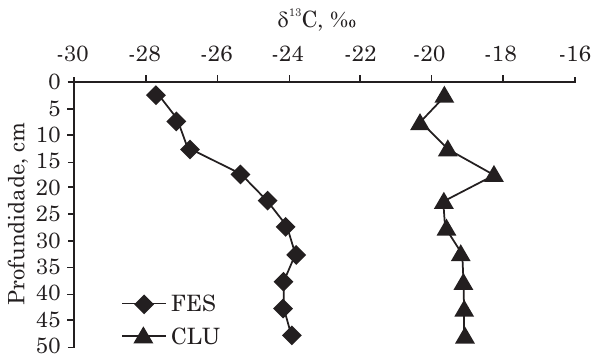
Figura 4. Valores médios de δδδδδ 13 C da MOS no Campo Limpo Úmido (CLU) e na Floresta Estacional Semidecidual (FES).